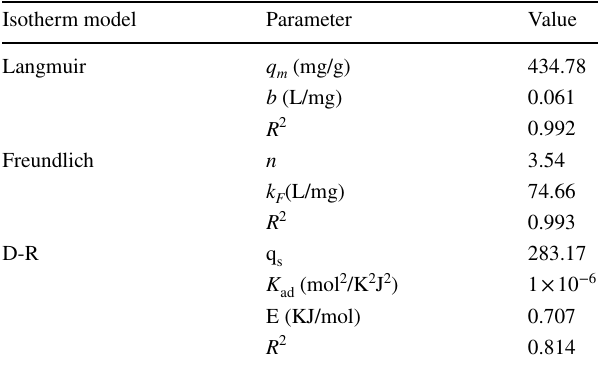
Table 1 Adsorption kinetic model parameters of the CR adsorption